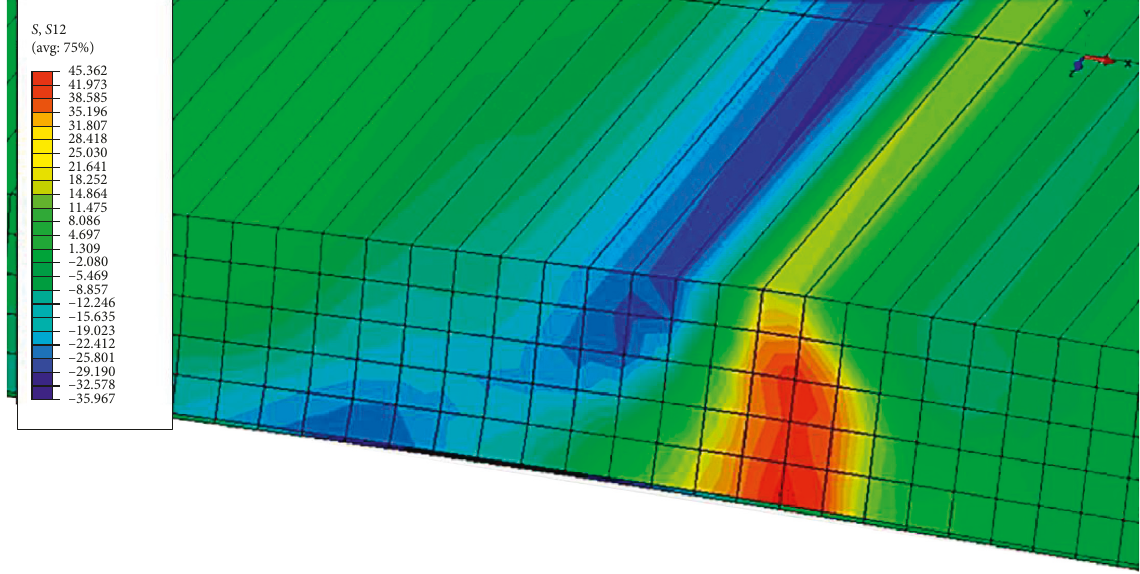
Figure 18: The distribution of tangential contact stresses in a thermal deformation hearth at K